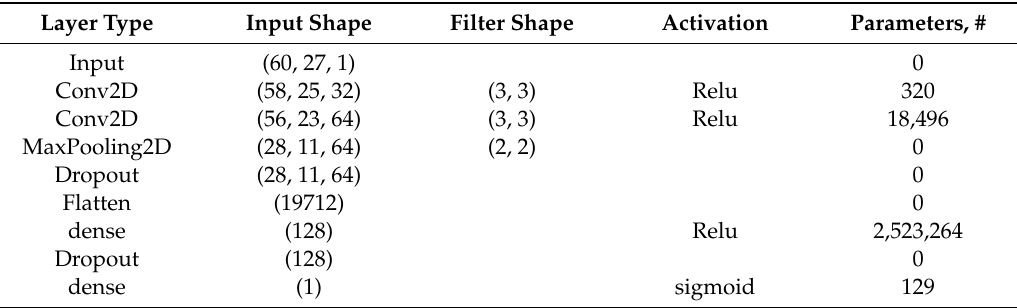
Table 4. Specifications of parameters for